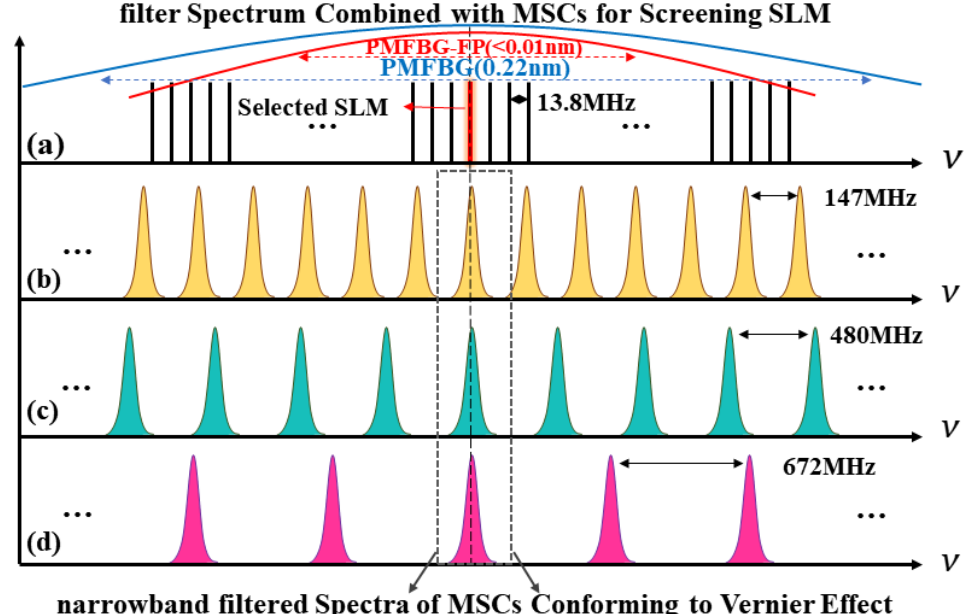
Figure 4. Schematic diagram of efficient FSR selection of SLM based on the Vernier effect. ( a ) Longitudinal mode spacing of the main cavity covered in the PMFBG and PMFBG ‐ FP filtered main peaks and the selected SLM; ( b–d ) are the FSRs of R 2 , R 1 , and R 3 , respectively.